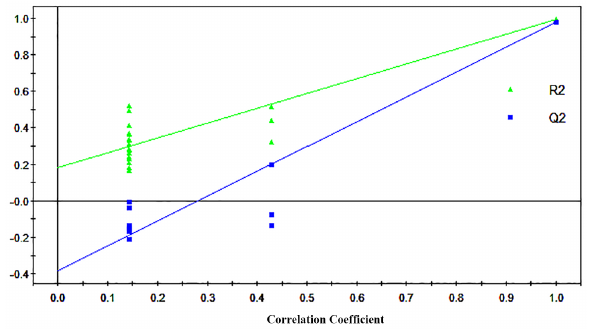
Figure 4: Validation plots based on the 1 H NMR spectra of Cabernet Sauvignon and Shiraz dry red wines. Green triangles and blue squares represent R 2 and Q 2 , respectively.